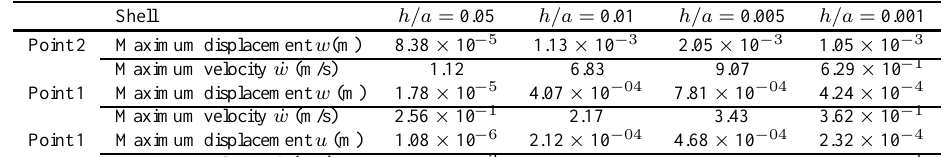
Table 6 Maximum displacements and velocities of shells with different thicknesses